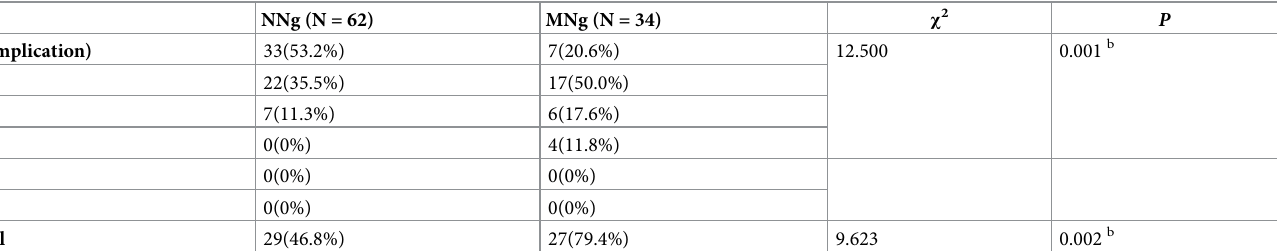
Comparison of postoperative recovery between NMg and MNg Average postoperative hospital stay-period of patients in MNg and NNg groups were 12.09 ± 6.48 and 10.61 ± 6.31 days, respectively (Fig 2A). The findings showed no significant difference in time of hospital stay between the two groups ( P > 0.05). Average hospitalization costs of MNg and NNg patients were 44358.65 ± 11767.69 and 39505.33 ± 7721.26 yuan, respectively (Fig 2B). Statistical analysis showed that the average hospitalization costs were sig- nificantly higher in MNg patients compared with those for NNg patients ( P < 0.01). Average duration of PACU of MNg and NNg patients were 3.12 ± 0.77 and 2.56 ± 1.12 hours, respec- tively (Fig 2C). Analysis showed that the average duration of PACU was longer in MNg patients compared with that of NNg patients ( P < 0.05). The findings showed that the average postoperative feeding time of MNg and NNg patients was 2.12 ± 1.77 and 2.26 ± 2.33 days, respectively (Fig 2D). Analysis showed no statistical difference in postoperative feeding time between the two groups ( P > 0.05). Table 3. Comparison of CDCS between the two